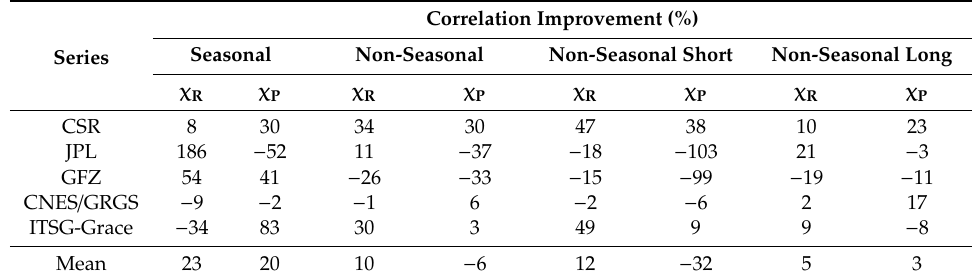
Table 3. Improvement in correlation between HAM and GAO for new GRACE solutions compared with the older solutions (positive, increased correlation; negative, decreased correlation).